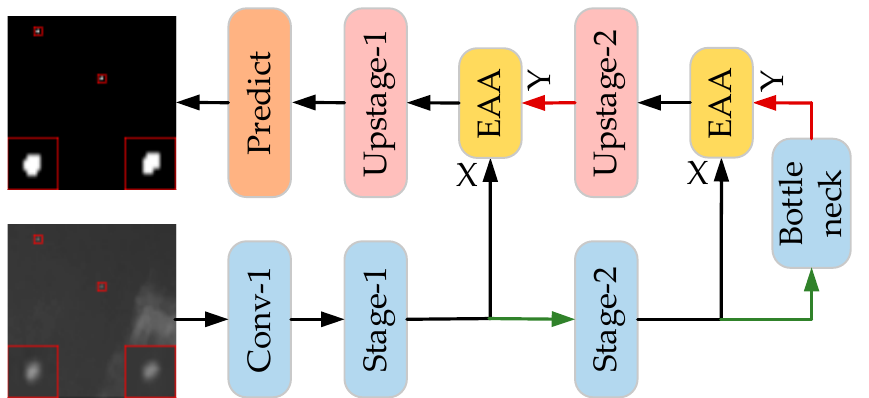
Figure 2. The proposed EAAU-Net, which incorporates the lower encoding module, the upper decoding module, and the enhanced asymmetric attention (EAA) module into a U-Net. The green line and red line represent the down-sampling and up-sampling operator, respectively.